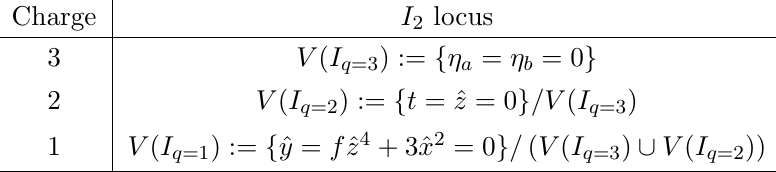
Table 2 . Charged matter loci for the q = 3 model.